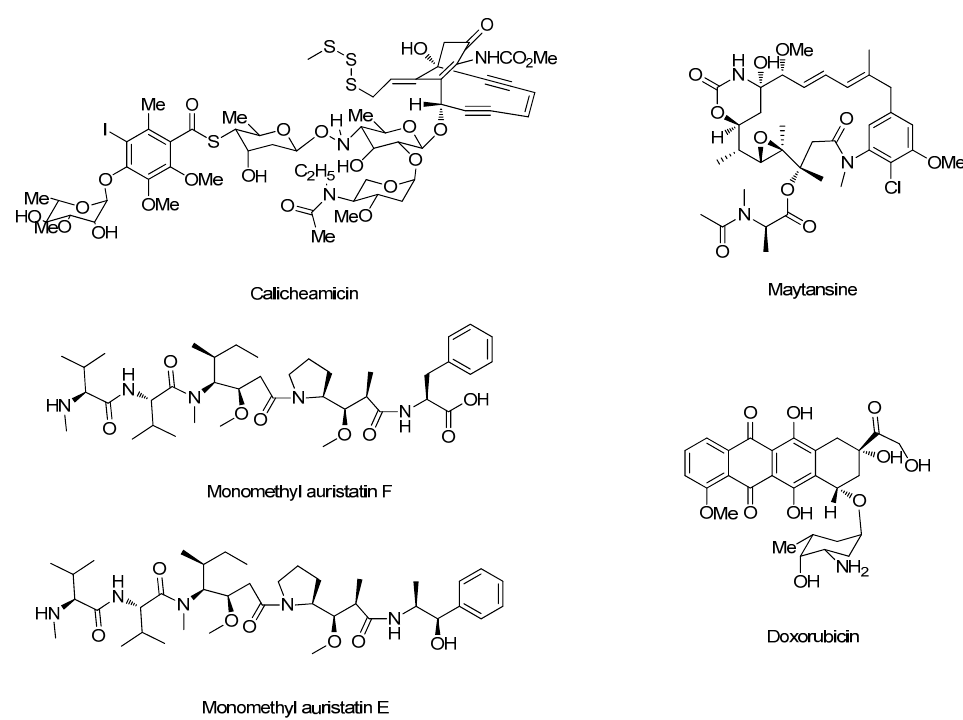
Figure 2. The structural formula of calicheamicin, maytansine, monomethyl auristatin F (MMAF), monomethyl auristatin E (MMAE), doxorubicin. Table 1. List of antibody–drug conjugates (ADCs) in clinical trials and Food and Drug Administration